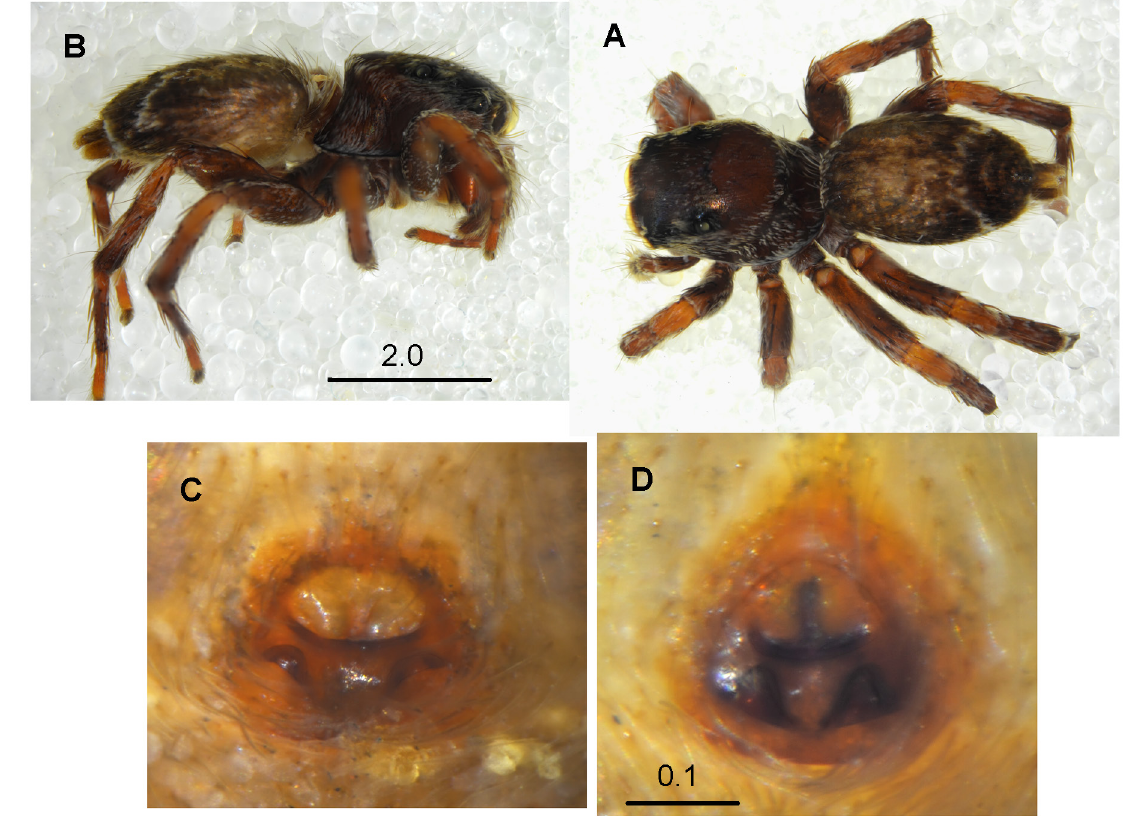
Fig. 9. Baryphas jullieni Simon, 1902, ♂♀ (MNHN). A . Habitus of male, dorsolateral view. B . Habitus of male, lateral view. C–D .